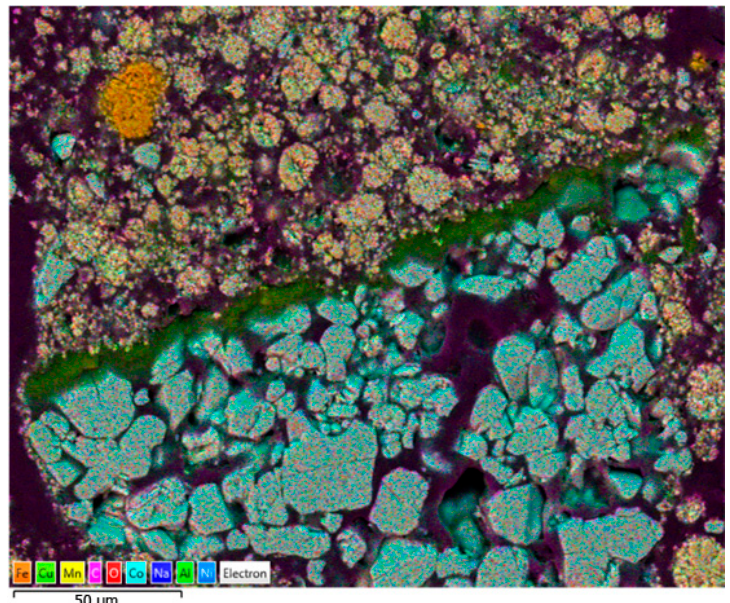
Figure 4. FESEM-EDS layered image of black mass powder sample.